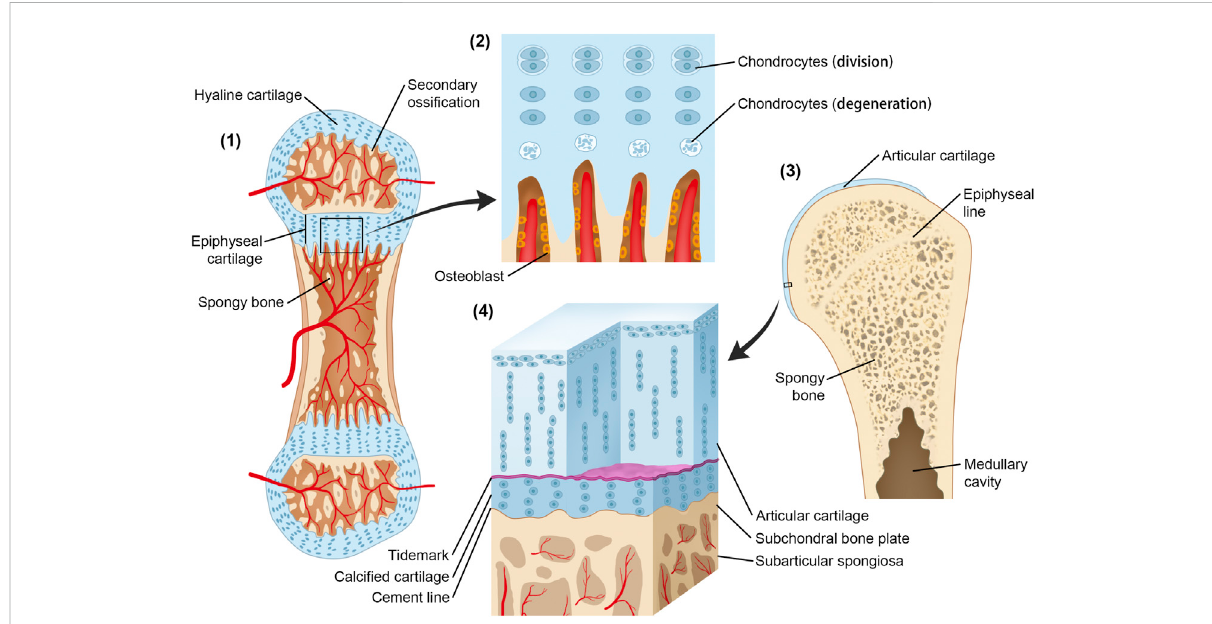
FIGURE 1 Origin and development of CCL and the growth plate. (1) Secondary ossi fi cation centers have formed. The initial structure of articular cartilage and growth plate comes from the same cartilaginous tissue. (2) Osteoblasts invade the lower boundary of the growth plate, replacing the cartilage with abone; atthesamerate,thegrowth plate enlarges throughinterstitialgrowth attheupperboundaryby chondrocyte division and enlargement. The epiphysis is pushed away from the diaphysis, and the bone length increases. In contrast, the height of the calci fi ed cartilage layer is maintained by the balance between tidemark advancement and bone transformation. (3) Following epiphyseal closure in adolescence, the calci fi ed cartilage layer remains quiescent but can be reactivated in the ageing process and OA. (4) Microscopic three-dimensional structure of